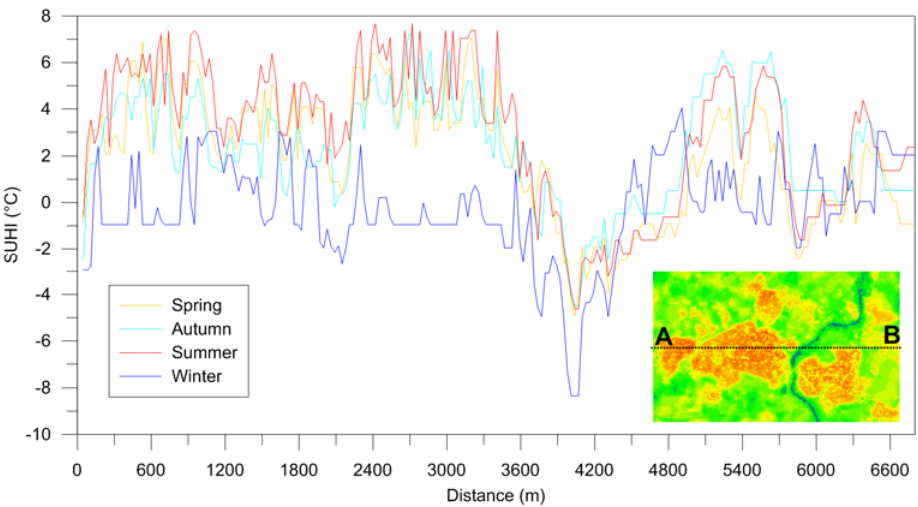
Figure 5. Spatial and seasonal variation of the average SUHIs along line A–B.